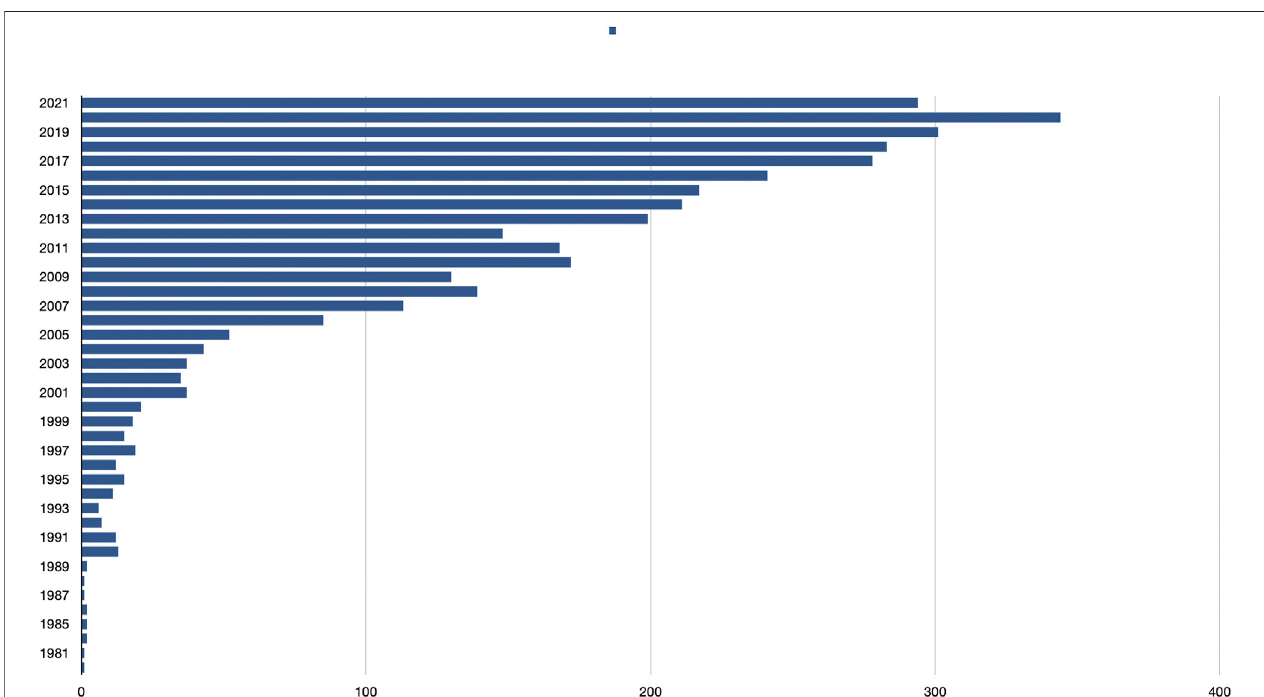
FIGURE 1 | Number of articles reported in PubMed by year on the topic “ biosurfactants ”